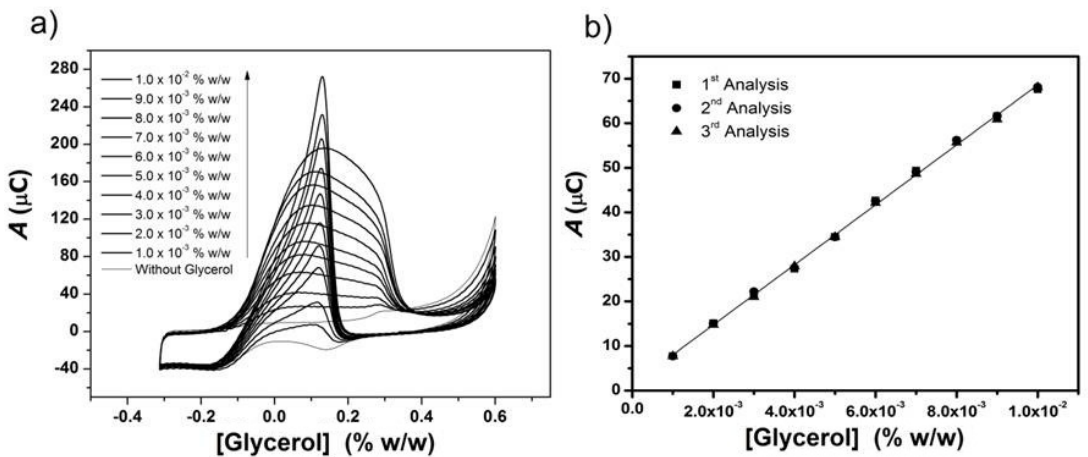
Figure 6. Cyclic voltammetric curves of GCE-ErGO-EAuNp for different glycerol concentrations to evaluate the linearity range of the method (a) and its analytical curve